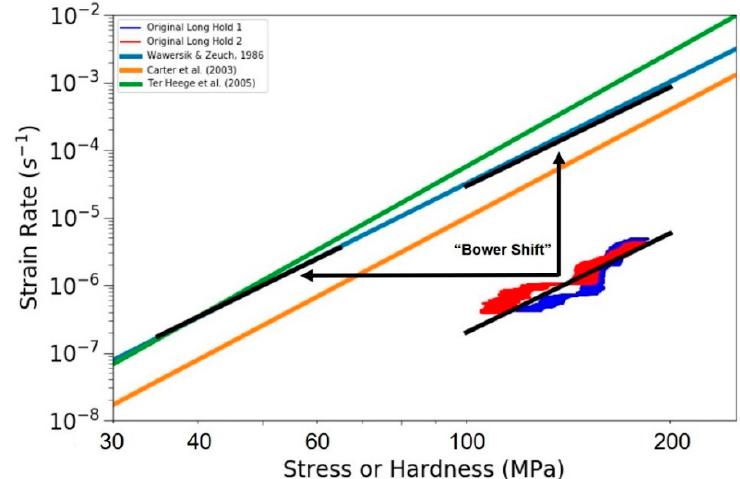
Figure 12. Plot of stress vs. strain rate illustrating the “Bower shift.” The raw data corresponding to the low-stress portions of the long-hold creep tests (where n = 4.87) are shown. Three different dislocation creep flow laws extrapolated to room temperature are shown for comparison. The black line, a fit to the raw data, is shifted according to Equation (12), either in the vertical or, equivalently, the horizontal direction. The two shifted black curves agree well with the predictions of the flow laws, particularly that of Wawersik and Zeuch [6].